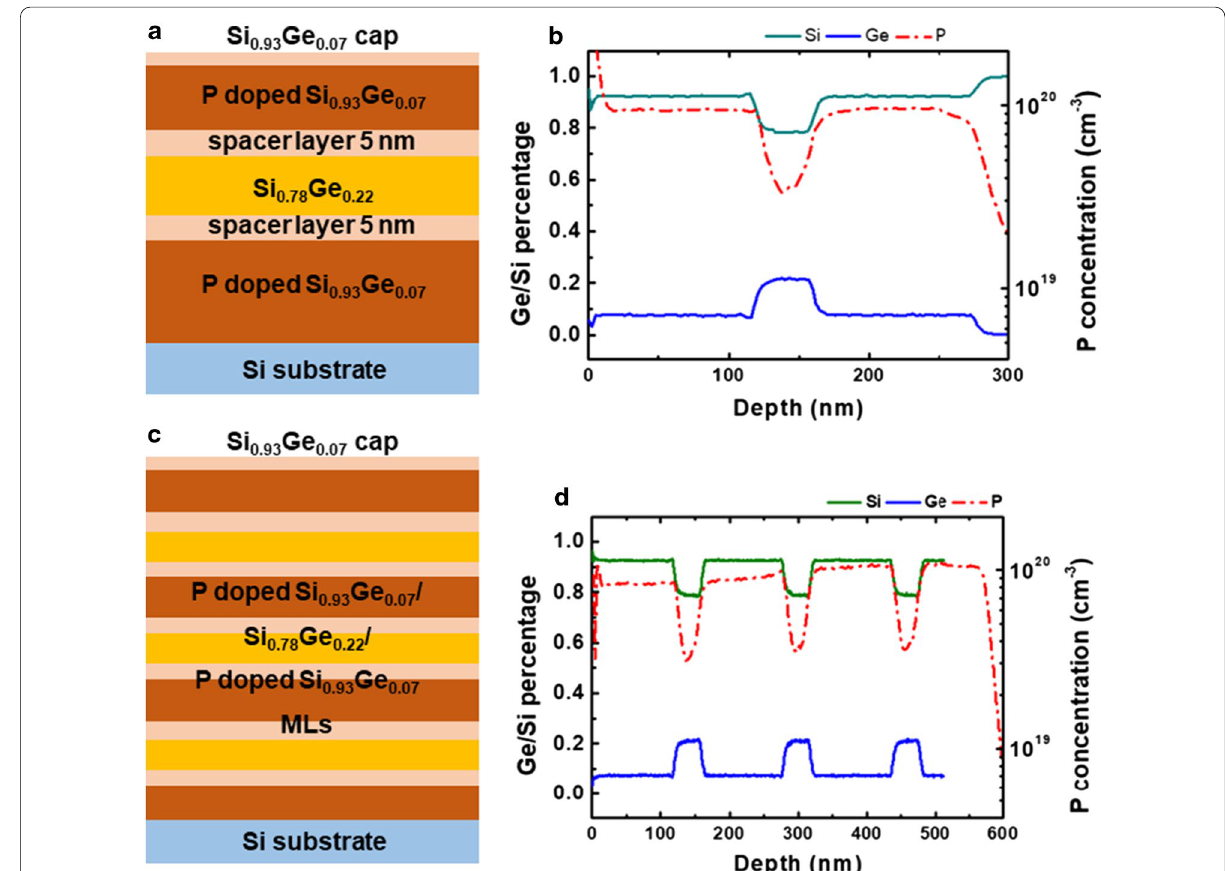
Fig. 5 a Schematic diagram, b Ge/Si and P profile in one layer of P-doped Si 0.93 Ge 0.07 /Si 0.78 Ge 0.22 /P-doped Si 0.93 Ge 0.07 ML. c Schematic diagram, d Ge/Si and P profile in three layers of P-doped Si 0.93 Ge 0.07 /Si 0.78 Ge 0.22 /P-doped Si 0.93 Ge 0.07